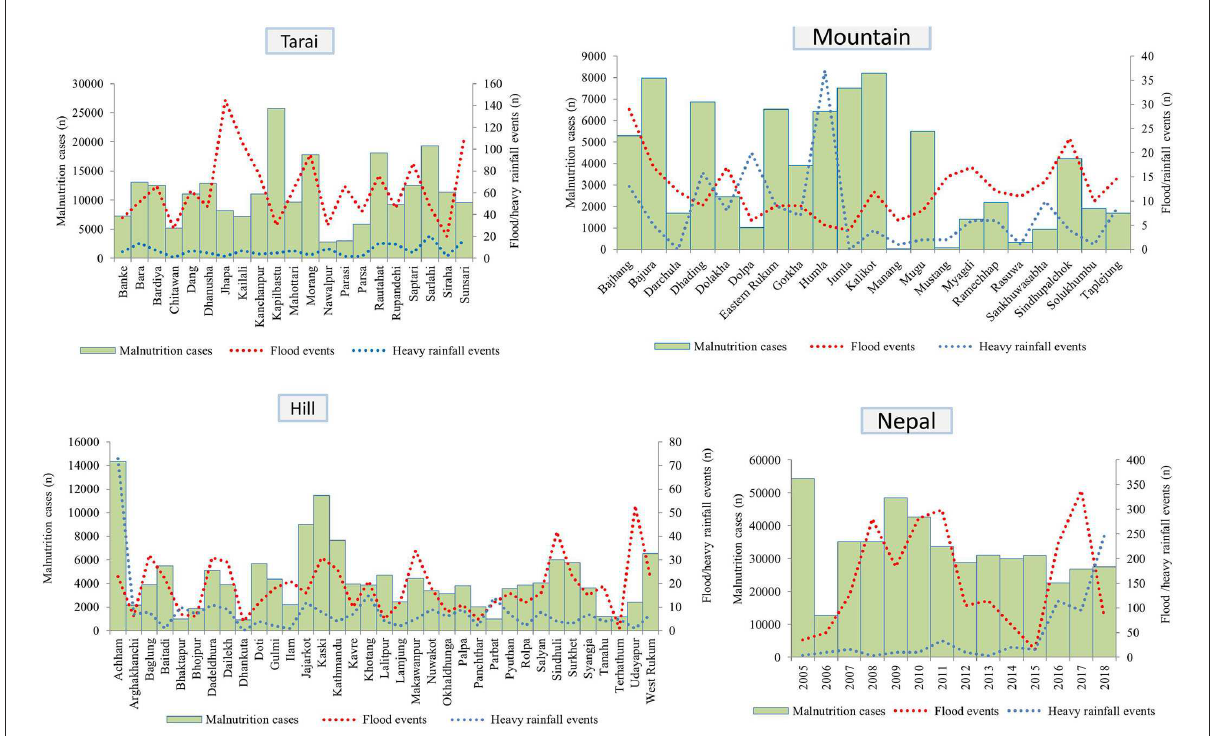
FIGURE3 Ecological and district-wise distribution of malnutrition cases, flood, and rainfall events from 2005 to 2018 in